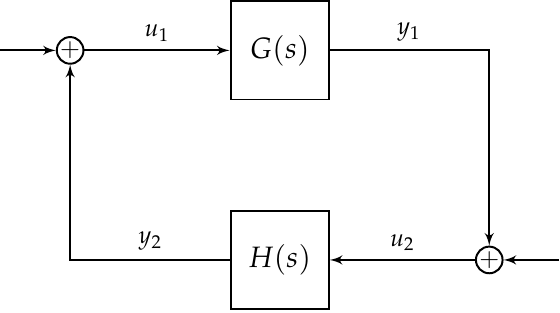
Figure 1. Positive feedback control systems of NI